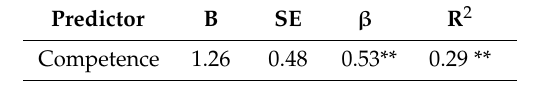
Table 2. E ff ect of satisfaction of need for competence on work alienation.